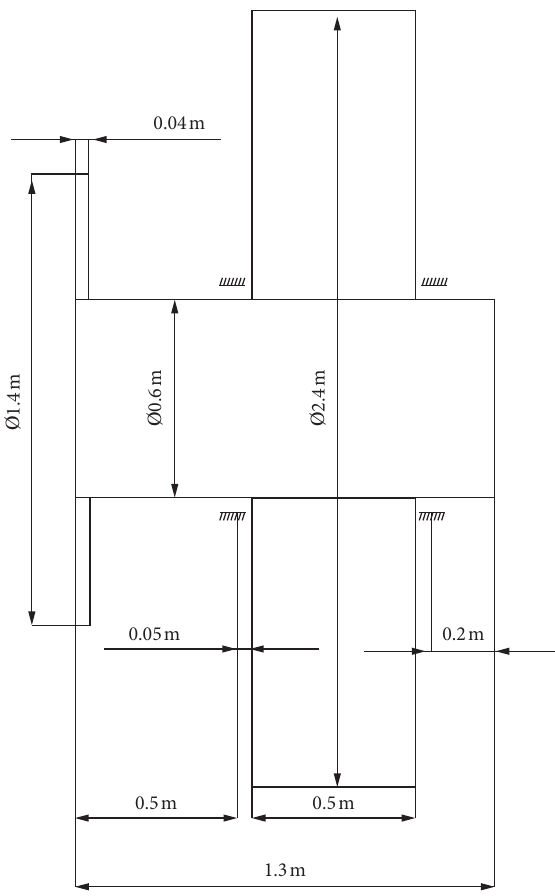
Figure 2: Structural parameter model of spindle system.